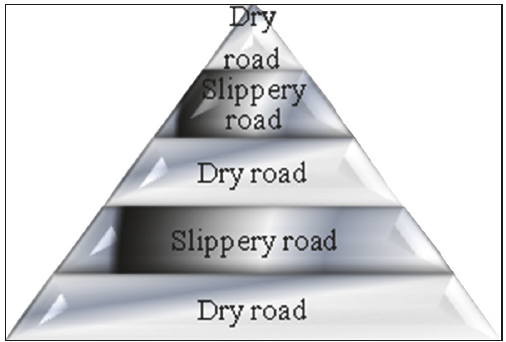
Figure 15: Test of the EV driven under different road